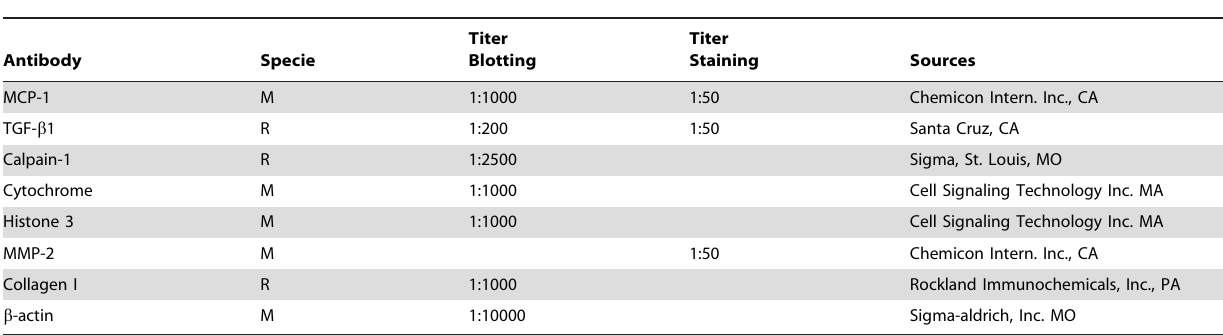
Table 1. Primary Antibodies.